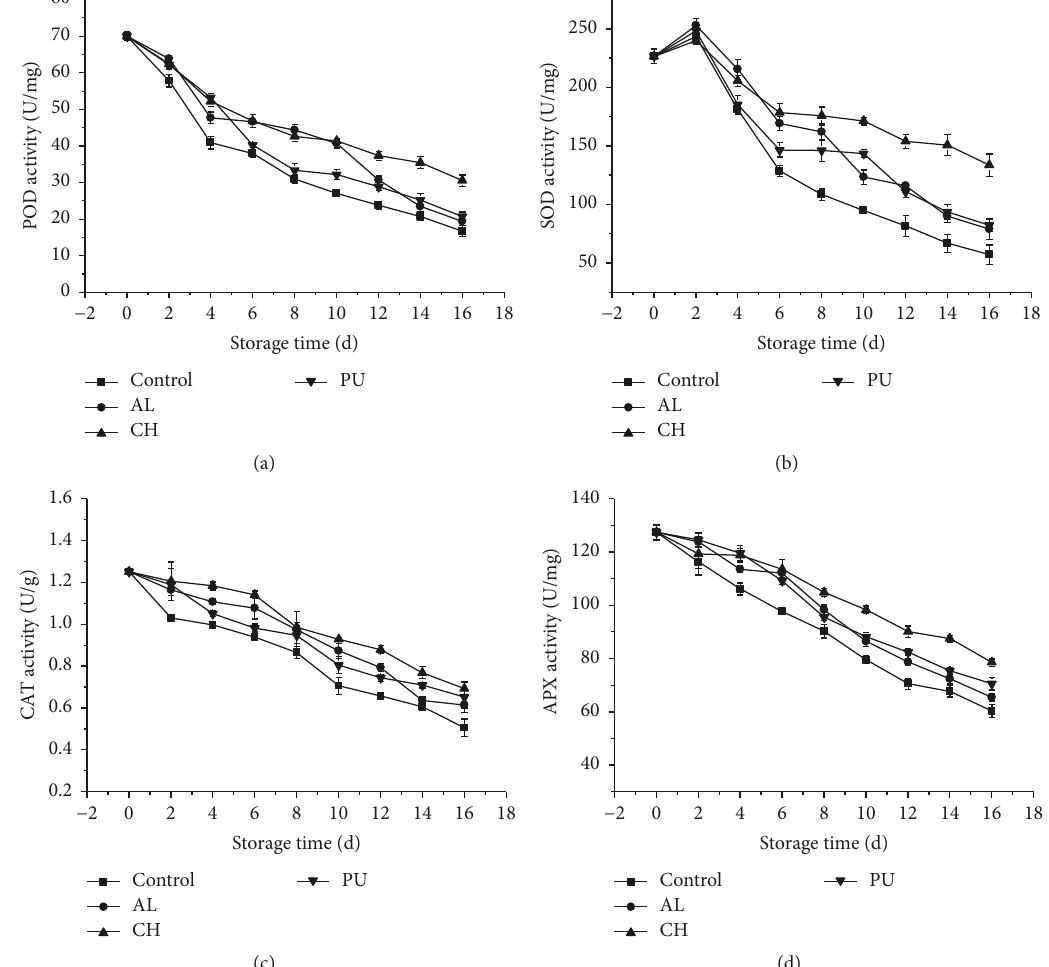
Figure 5: Effects of three different polysaccharide-based edible coatings on POD (a), SOD (b), CAT (c), and APX (d) activities of